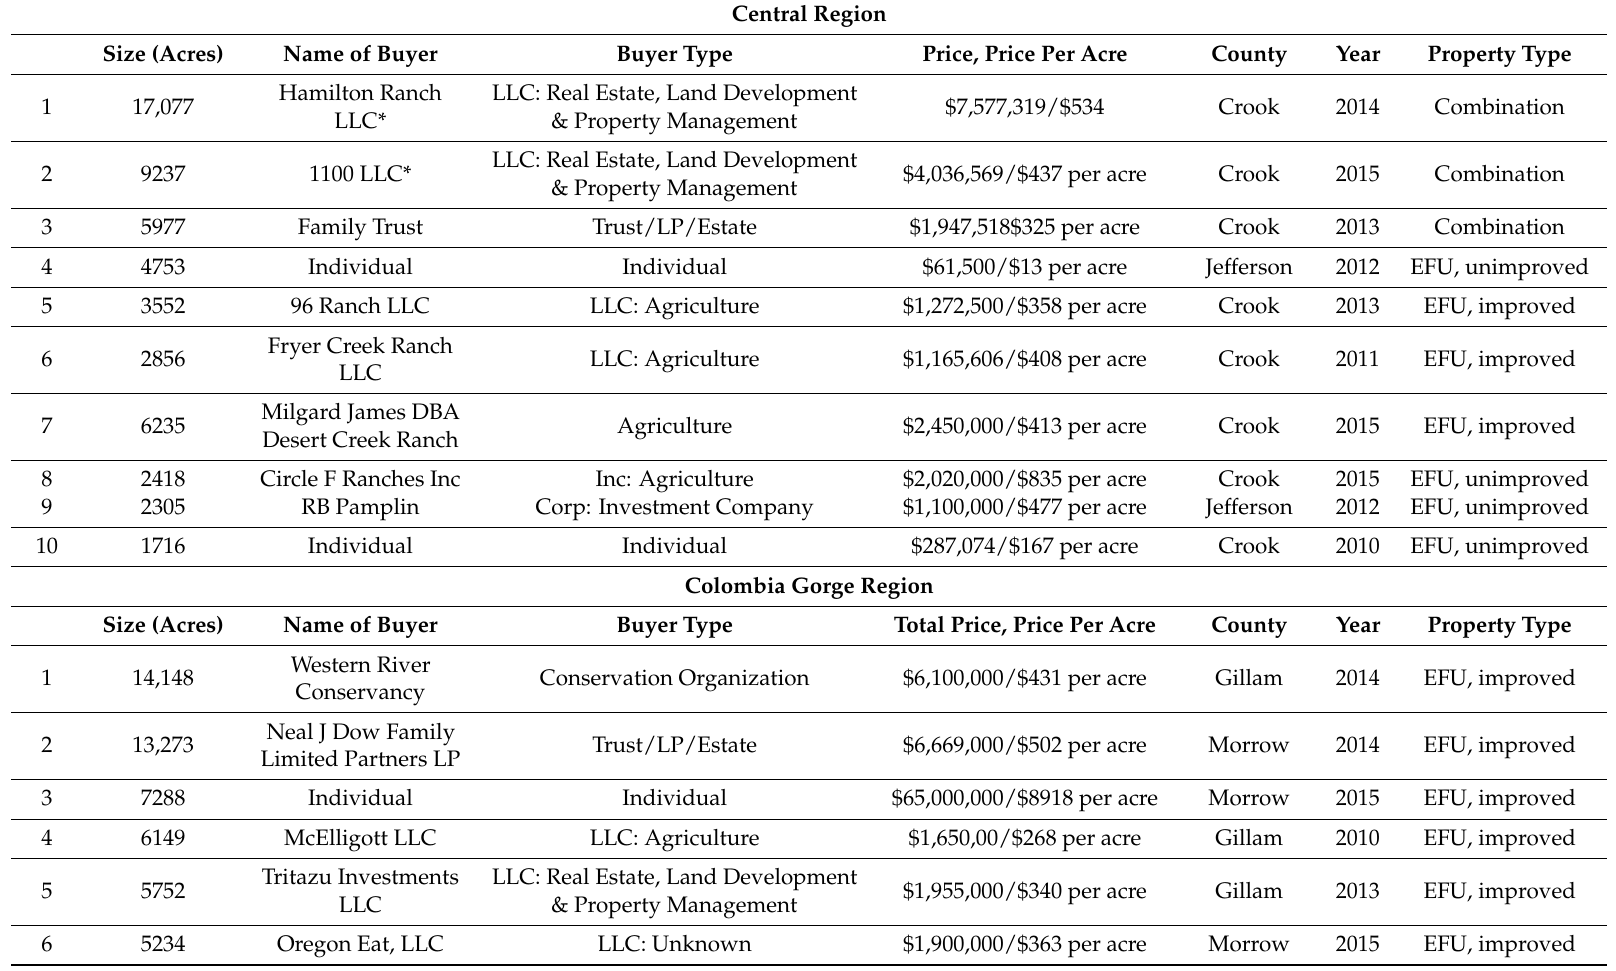
Table 3. Top 10 purchasers by acreage (2010–2015). Central